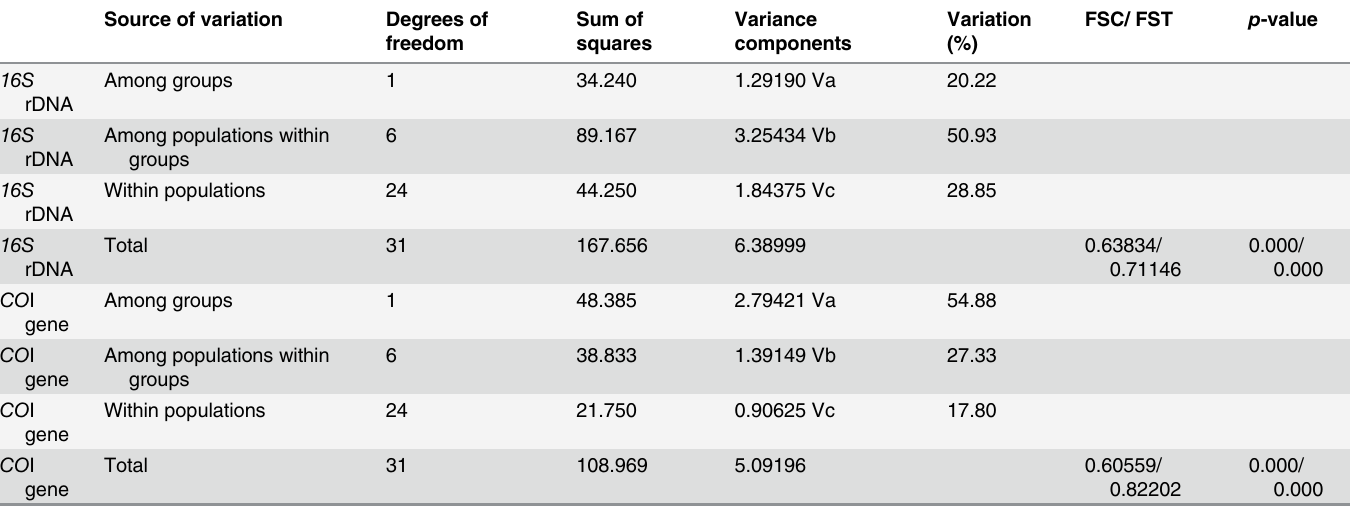
Table 6. Analysis of molecular variance (AMOVA) based on the 16S rDNA and CO I gene sequences of D . pulex about the two groups (middle reach vs. lower reach) in the Yangtze River. Source of variation Degrees of freedom Among groups Among populations within groups